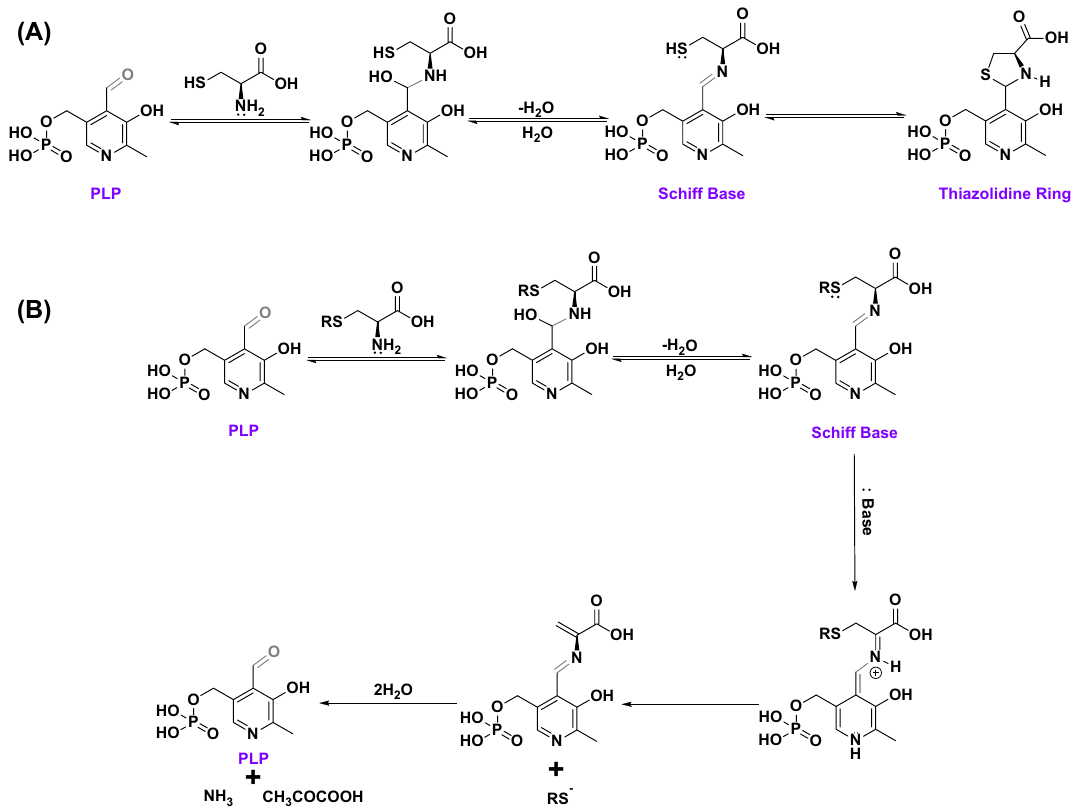
Figure 1. Proposed reaction mechanism of enzyme-independent chemical interaction of PLP with cysteine. (A) Mechanism of the formation of thiazolidine ring with PLP and cysteine in the absence of a base and metal ions. Formation of Schiff base is an intermediate step. (B) Mechanism for the catalytic behavior of PLP on reaction with S -substituted cysteines in slightly alkaline conditions. PLP is regenerated producing S -substituted analogs, ammonia, and